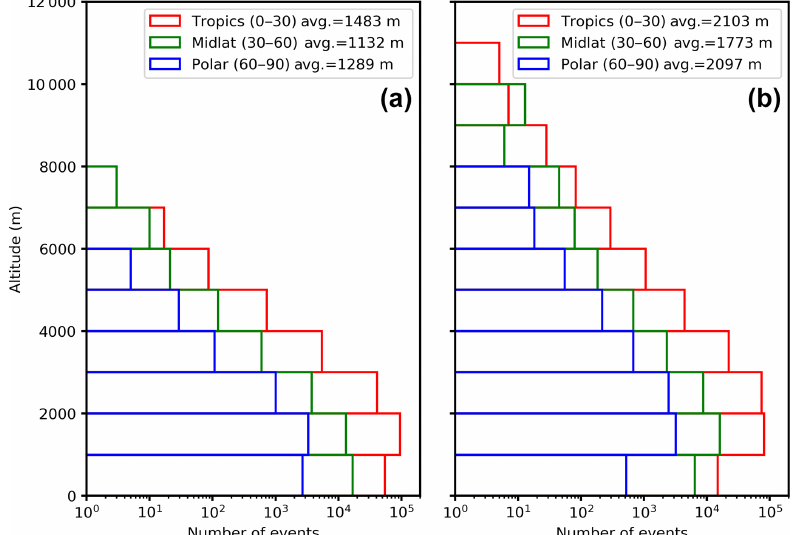
Figure 7. Vertical distribution of GFAS plume rise parameters over 2013 at a 1 ◦ longitude × 1 ◦ latitude resolution. (a) Injection height and (b) plume top